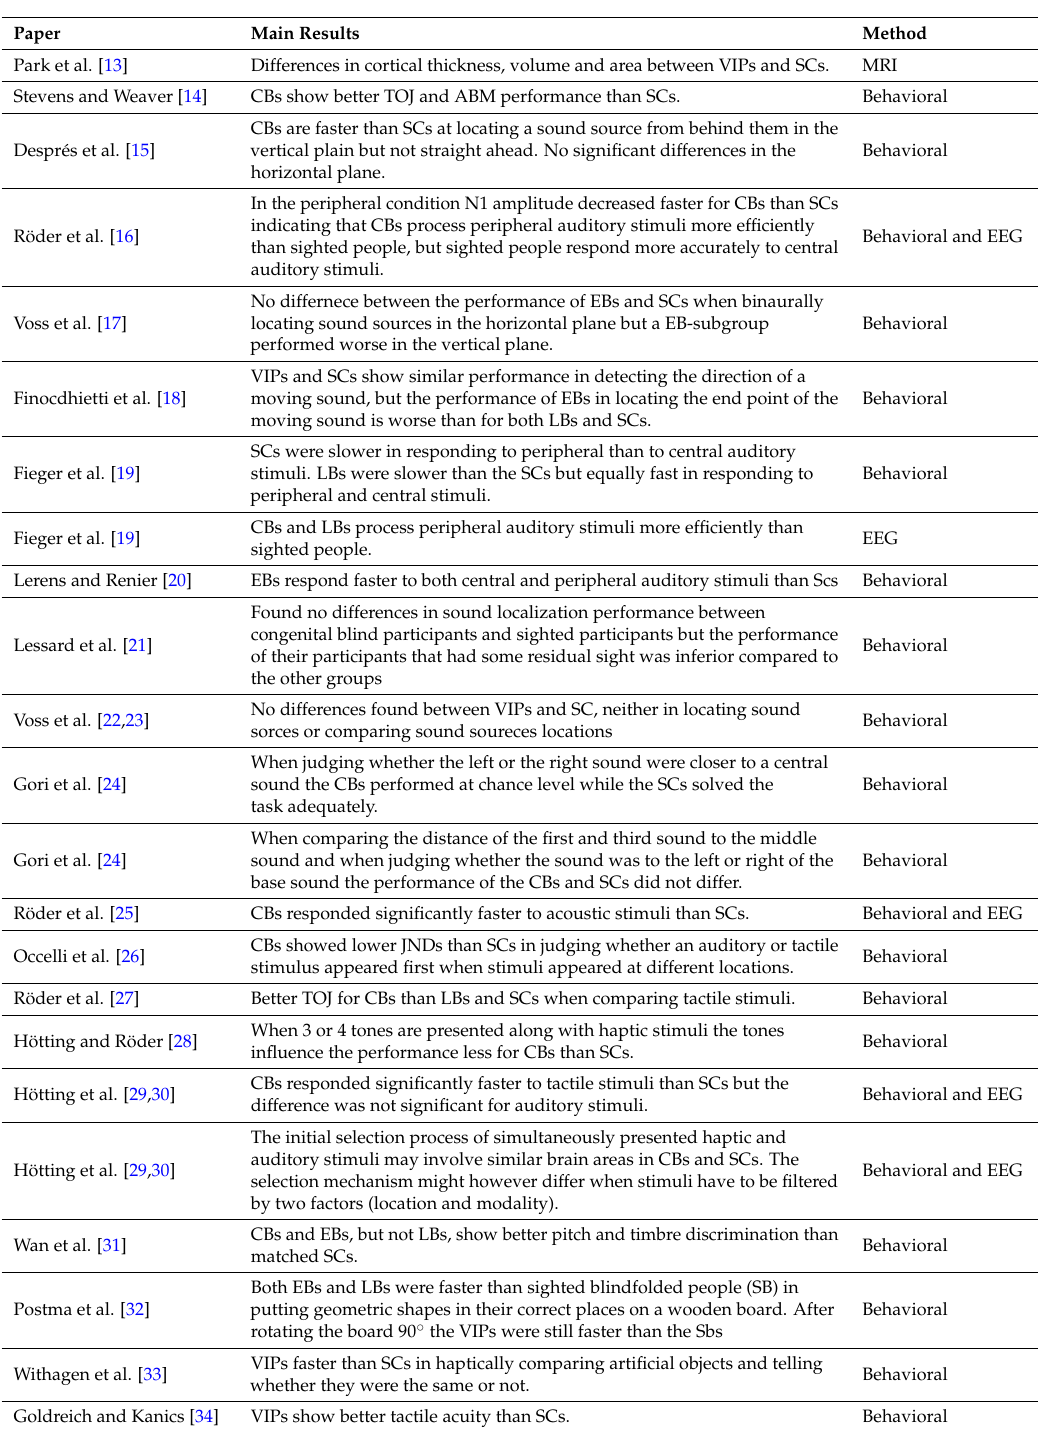
Table 1. Overview of the results reviewed in Section 2, presenting evidence for structural and functional differences in auditory and haptic perception between visually impaired and sighted